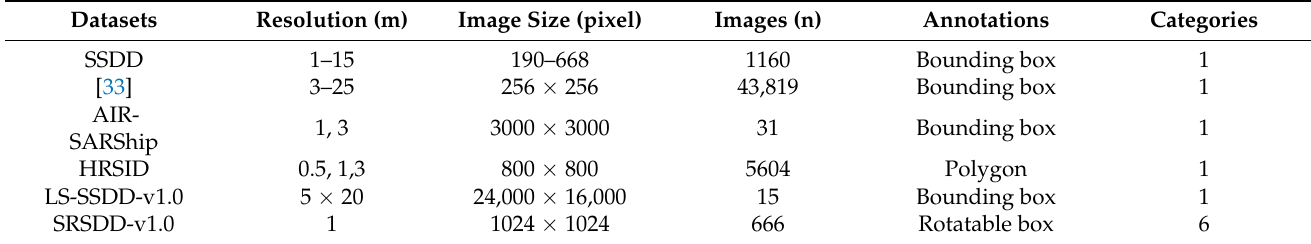
Table 3. Statistics of several SAR ship detection data sets.